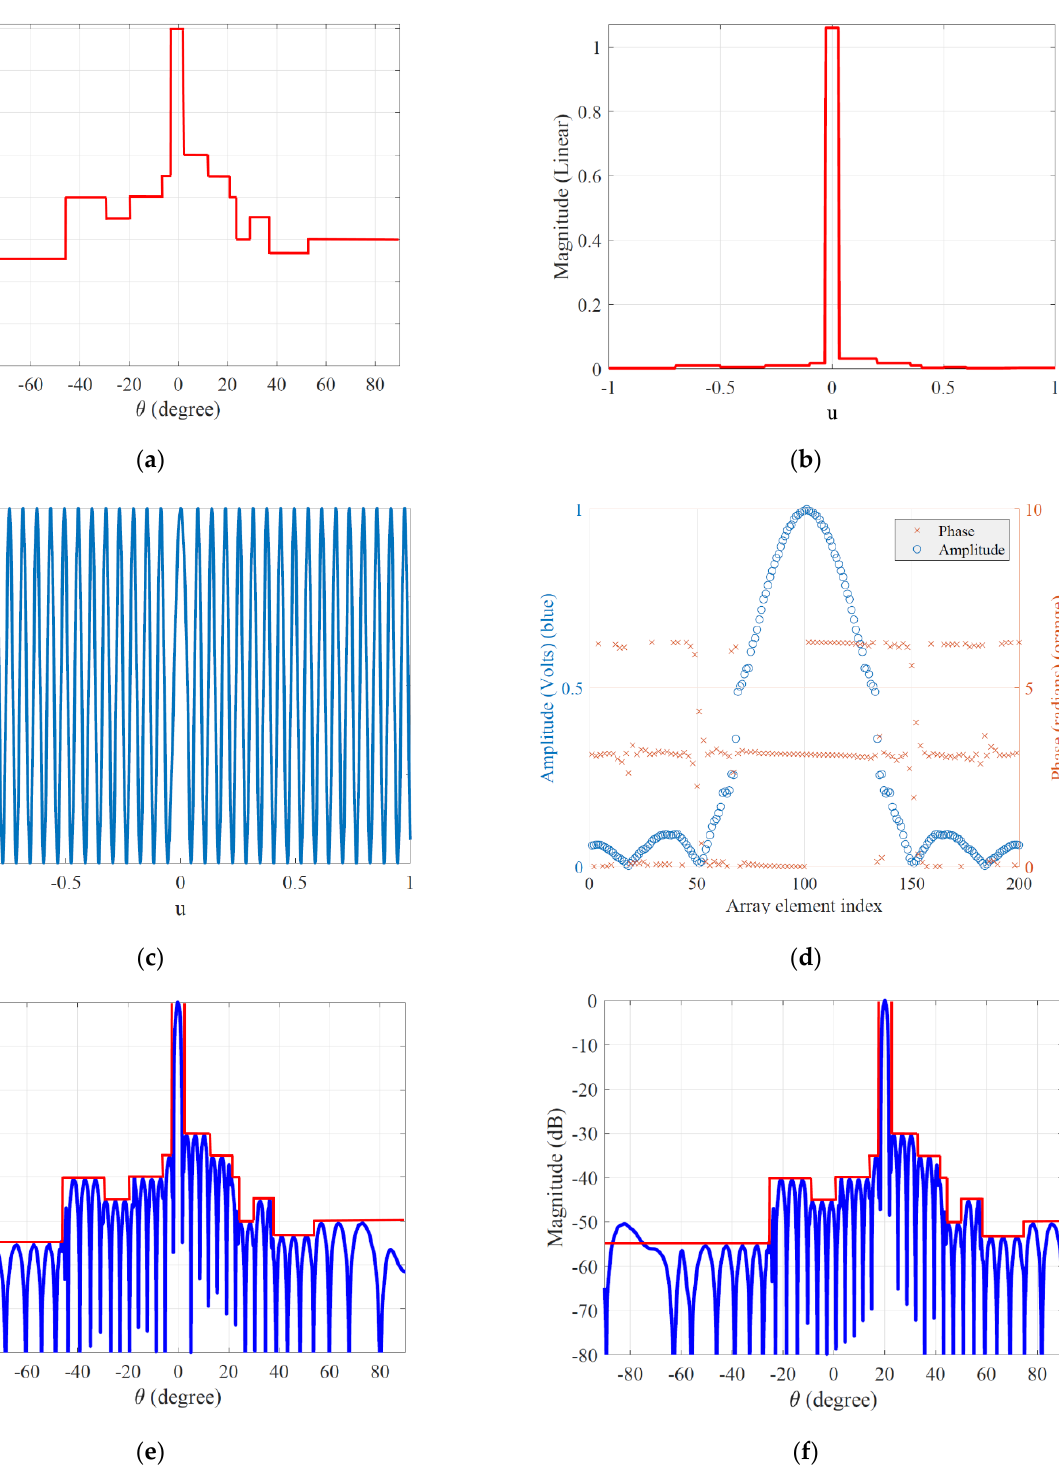
Figure 2. ( a ) Designed mask template in dB scale; ( b ) Designed mask template in linear scale; ( c ) Designed waveform pattern; ( d ) A set of element excitations calculated using ( c ) and ( b ) with respect to both amplitude (blue) and phase (orange); ( e ) The desired AF synthesized by a set of element excitations of ( d ); ( f ) The desired AF synthesis steered towards 20 degrees in the presence of defec-tive elements.